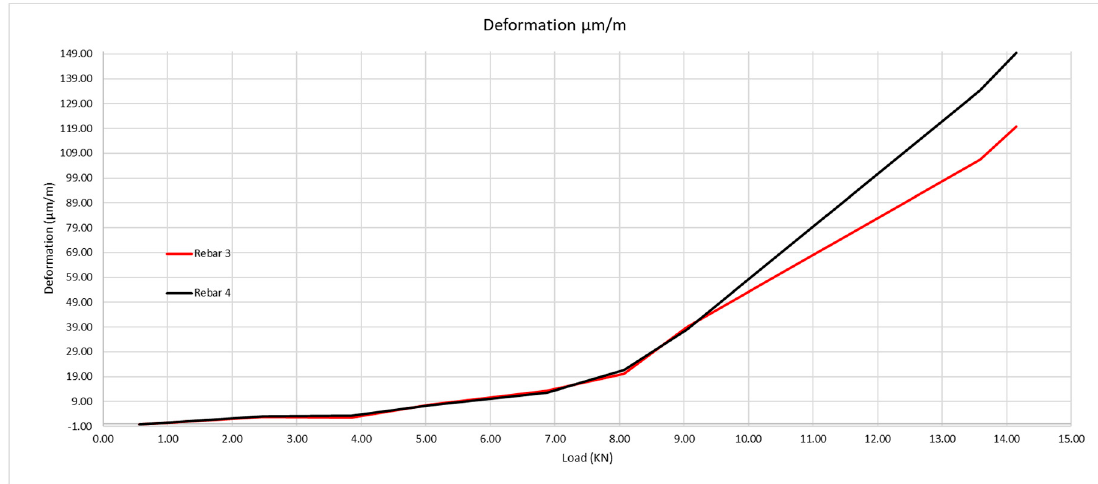
Figure 14. Deformation of rebars according to the loads applied.